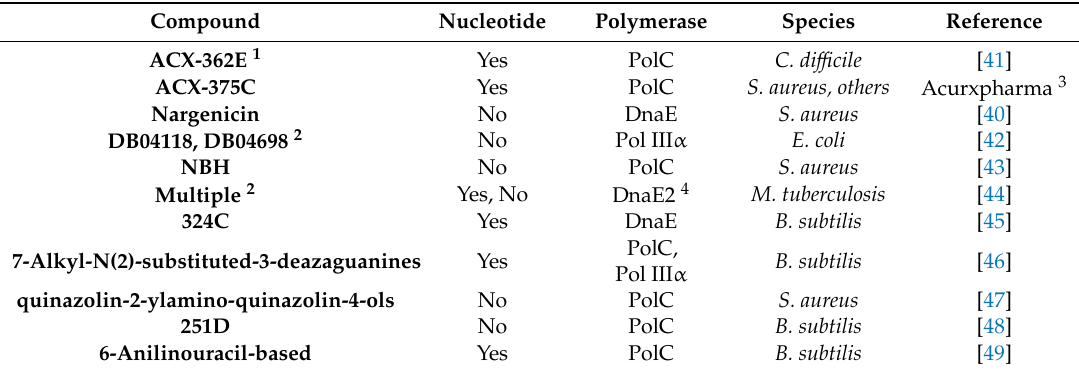
Table 1. Bacterial DNA polymerase